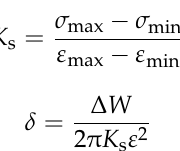
Figure 1. Characteristic points of austenite SMA constitutive curve. The mechanical performance indicators are defined as follows: ∆ W represents the energy consumption value of the SMA wire in a single cycle, that is, the graphic area enclosed by the stress–strain curve; K s represents the equivalent secant stiffness of a single cycle; δ represents the equivalent damping ratio of a single